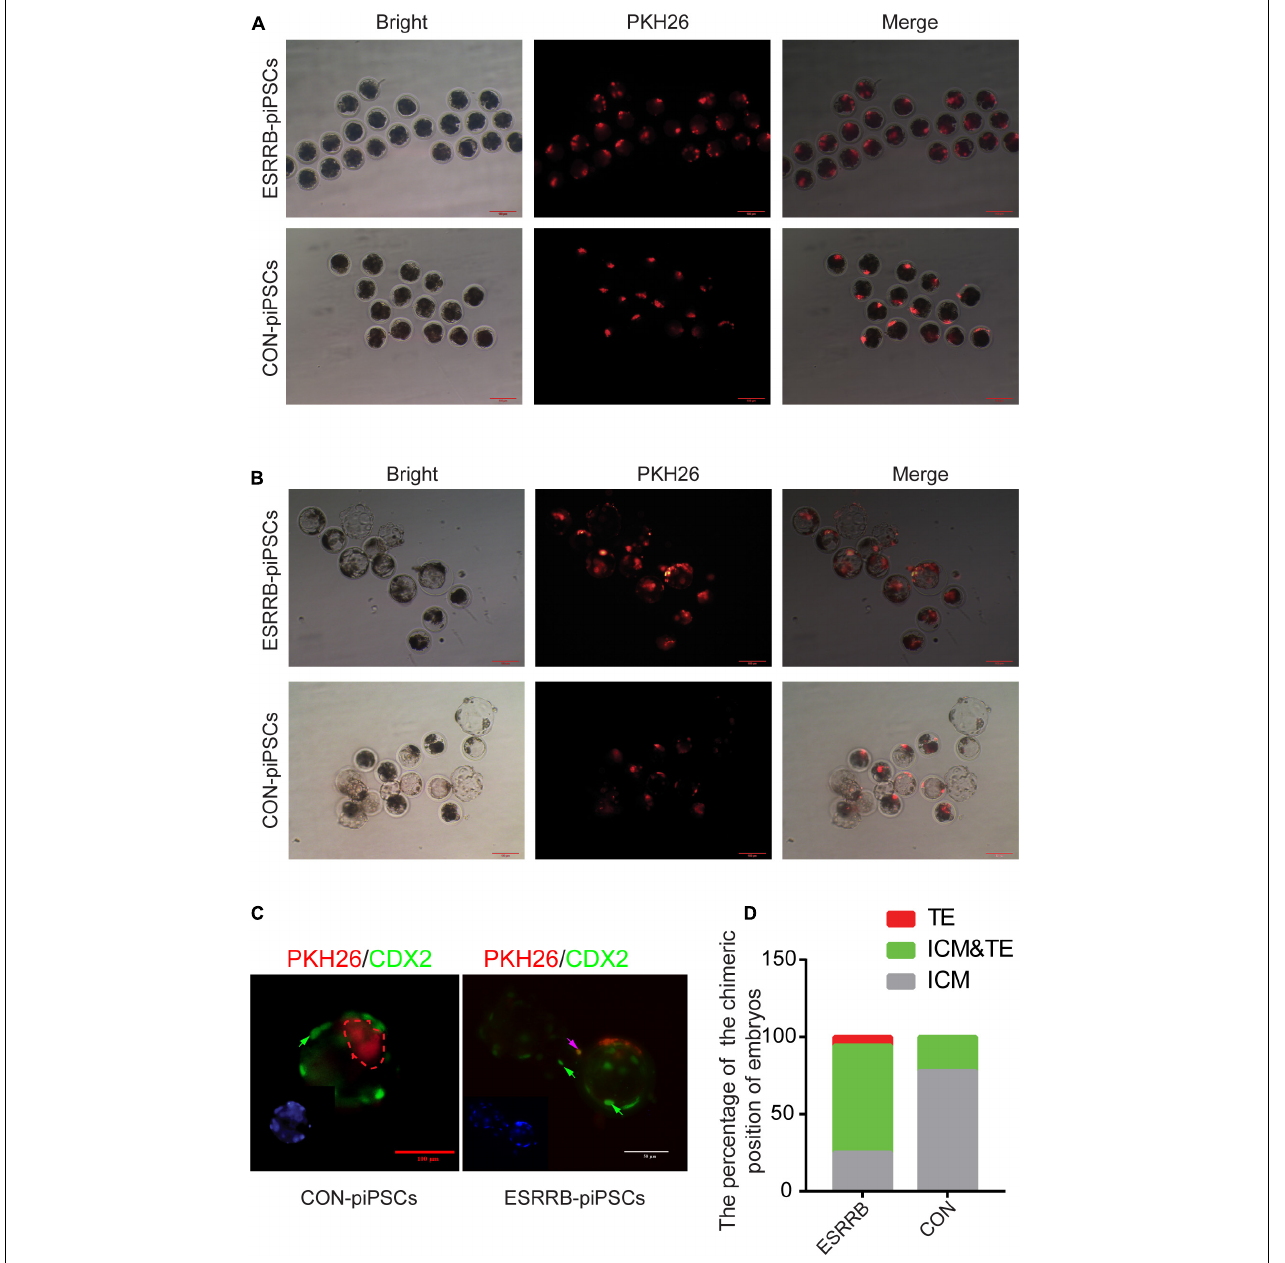
FIGURE 2 | Overexpression of ESRRB in greater chimeric ability into trophoblast. (A) The localization of injected CON- and ESRRB-piPSCs in early eight-cell pig embryo; the scale bar represents 100 µ m. (B) The localization of injected CON- and ESRRB-piPSCs chimeric embryos after 72 h culture in vitro ; the scale bar represents 100 µ m. (C) The localization of injected ESRRB-piPSC chimeric blastocysts in vitro . The TE was indicated by immunofluorescence of CDX2. The nuclei were Hoechst33342 stained, and the donor cells were indicated by PKH26 staining in red fluorescence. The green arrow represents the CDX2-positive cells, and the pink arrow represents CDX2 and PKH26-double positive cells. The scale bar represents 50 µ m. (D) The quantitative analysis of contributing cell localization in embryos is shown by histogram.